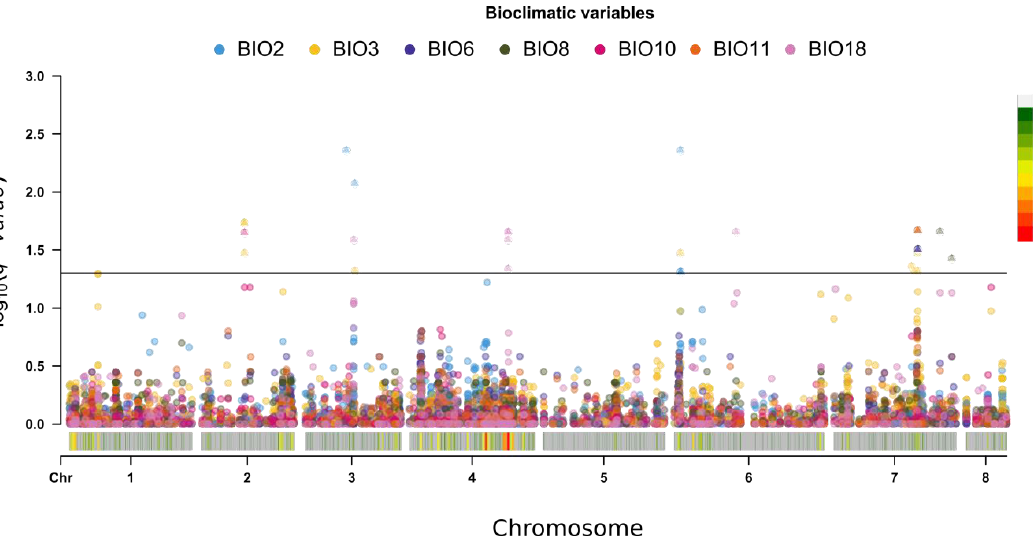
Figure 7. Summary of GWAS analyses with eight PCs as covariates for bioclimatic variables (different colors correspond to different bioclimatic variables). SNPs with q -value < 0.05 are shown for each chromosome, marked as triangles.